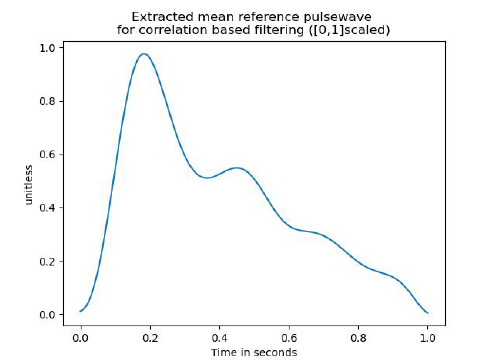
Figure 7. Extracted mean reference pulse wave for correlation-based